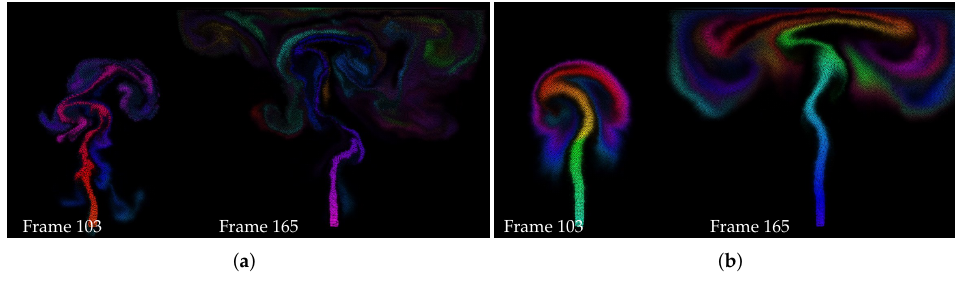
Figure 8. Comparison of 2D particle-based smoke simulation results. The related video has been submitted as Supplementary Material. ( a ) Our method. ( b ) Without angular momentum.